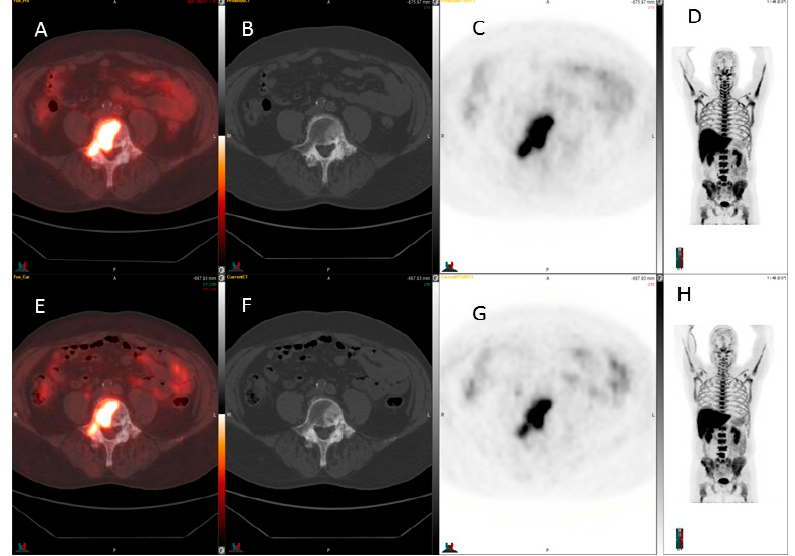
Figure 3. 18 F-FLT detection of prostate cancer metastases before and after therapy. The sclerotic skeletal metastases seen on CT are seen as defects on 18 F-FLT, so the usefulness of 18 F-FLT for detection of skeletal metastases is still unclear since visualization of lesions may be hindered by prominent background activity in the bone marrow. The skeletal metastases visualize most often as defects. Upper row, baseline: from the left fusion image ( A ), CT image ( B ), 18 F-FLT PET image ( C ), and MIP image ( D ); lower row, after 4 week therapy: from the left fusion image ( E ), CT image ( F ), 18 F-FLT PET image ( G ), and MIP image ( H ). Color bar range from 0 to 5.